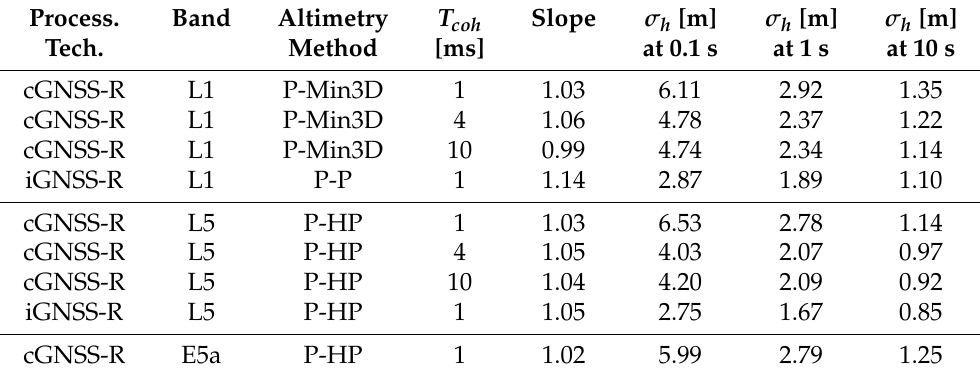
Table 3. Unbiased root mean squared error (ubRMSE, σ h ), with respect CryoSat-2, for the computed bands, altimetric methods and coherent times. For T incoh = 0.1, 1 and 10 s. The slopes are computed from the fit with respect to the CryoSat-2 data using T incoh = 100 ms, as in Table 2.